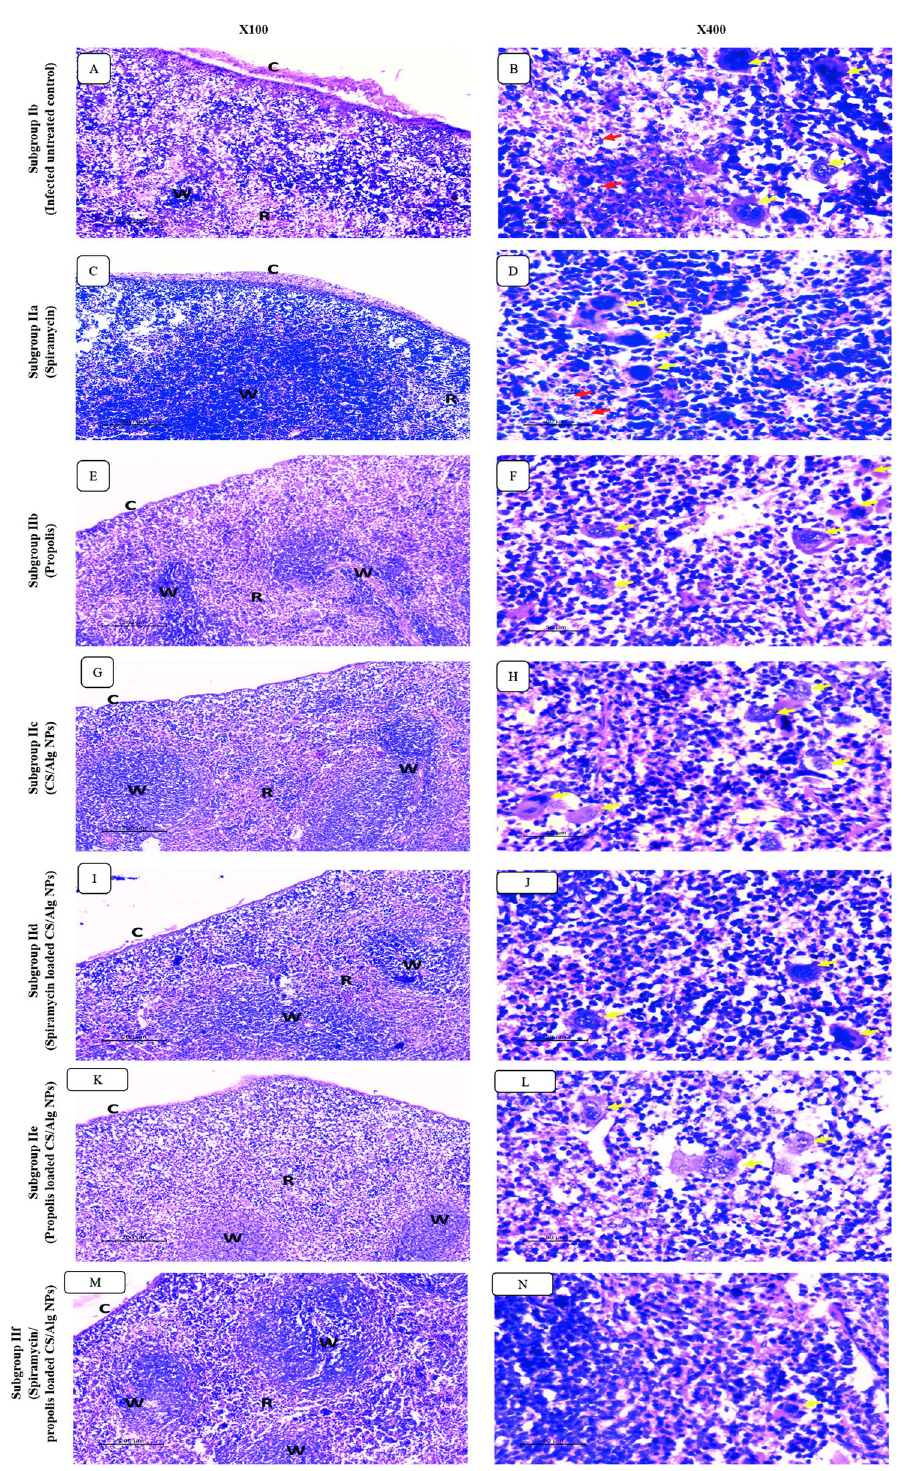
Fig 9. Sections of splenic tissues in infected untreated group (A-B) and treated groups with different regimens (C-N). (A) Infected untreated group showing perisplenitis (c) and severe congestion of red pulp (R) which occupied most of splenic architecture in expanse of white pulp (W). (B) High power view showing increased number of histiocytes and megakaryocytes (yellow arrows) with numerous parasites (red arrow) in infected untreated group. (C-N) Perisplenitis (C), red pulp congestion (R) and the count of megakaryocytes/histiocytes (yellow arrows) improved in different degrees in the treated groups.